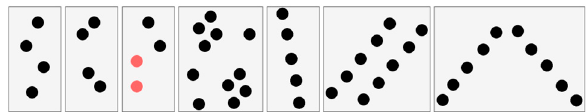
Figure 2: Visual patterns on points from left to right: Not grouped; Proximity criterion; Similarity criterion; Common cluster region; Linear criterion; Parallel criterion: Symmetry criterion.